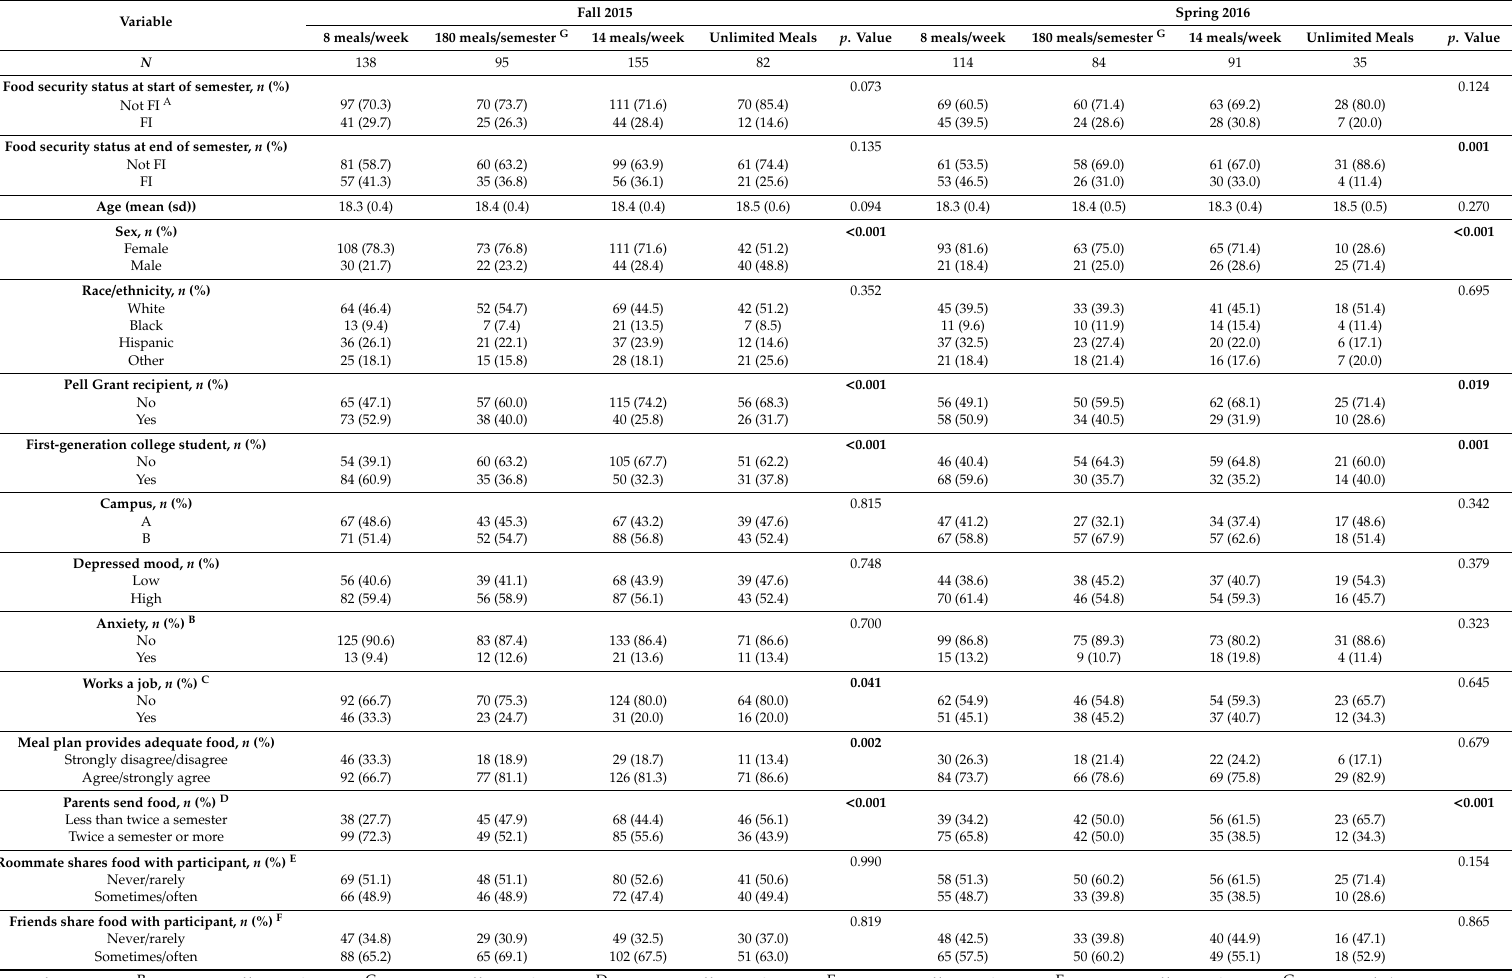
Table 1. Demographics and key variables by the meal plan purchased in the Fall 2015 ( n = 470), and Spring 2016 ( n = 324)